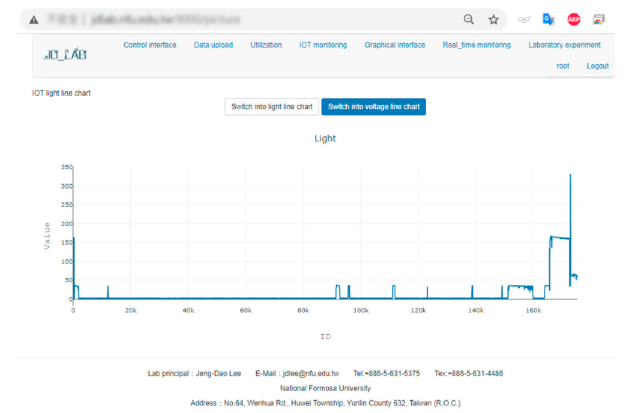
Figure 19. IoT graphical